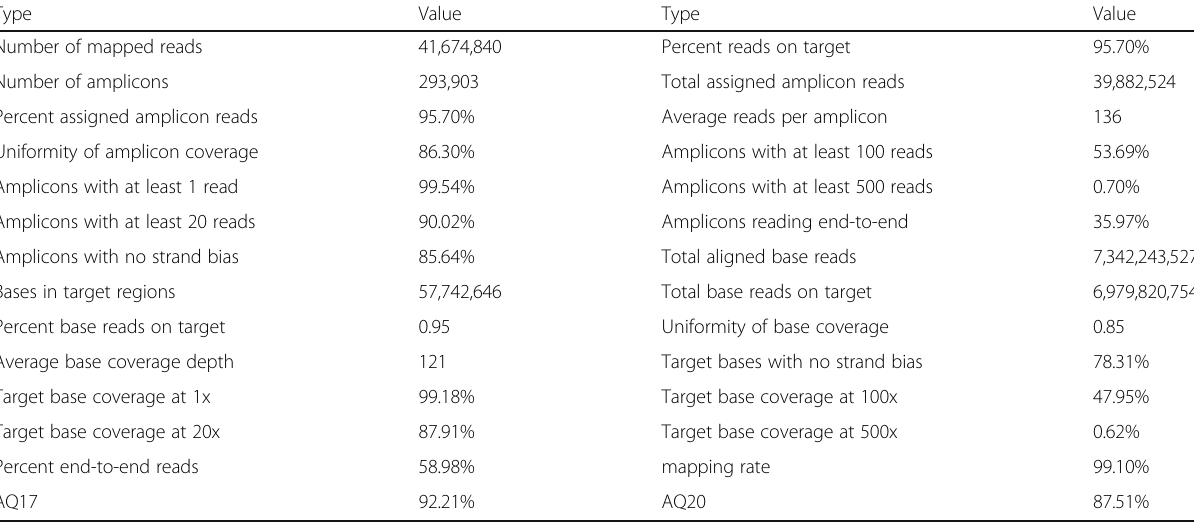
Table 1 Whole Exome Sequencing detail of coverage and number of reads for patient one family I. Other whole exome sequencing results have similar depth and coverage metrics